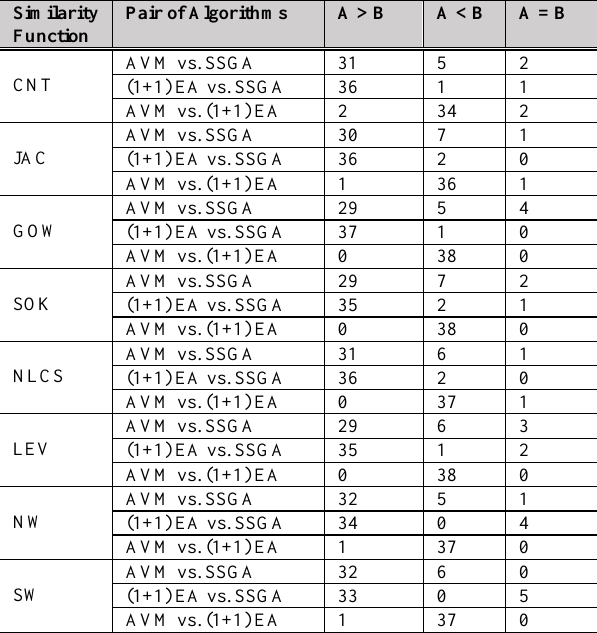
Table 2. Results for RQ2 using Vargha and Delaney statistics and Mann–Whitney U test at significance level of